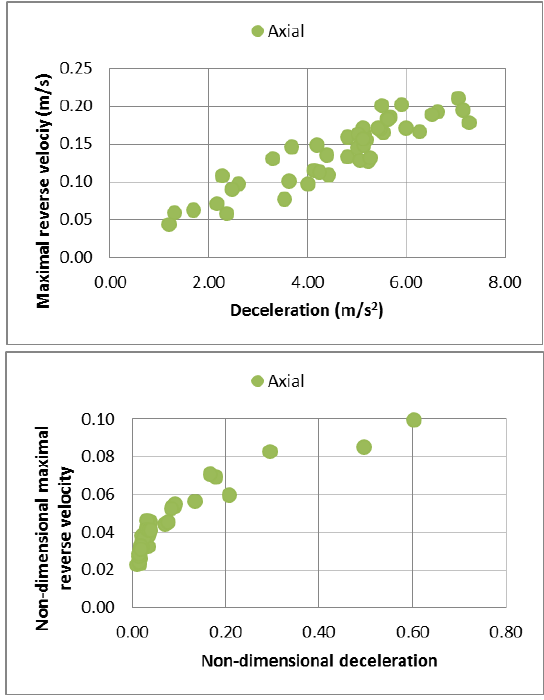
Fig. 17. Dynamic properties – reverse velocity dependence on system deceleration